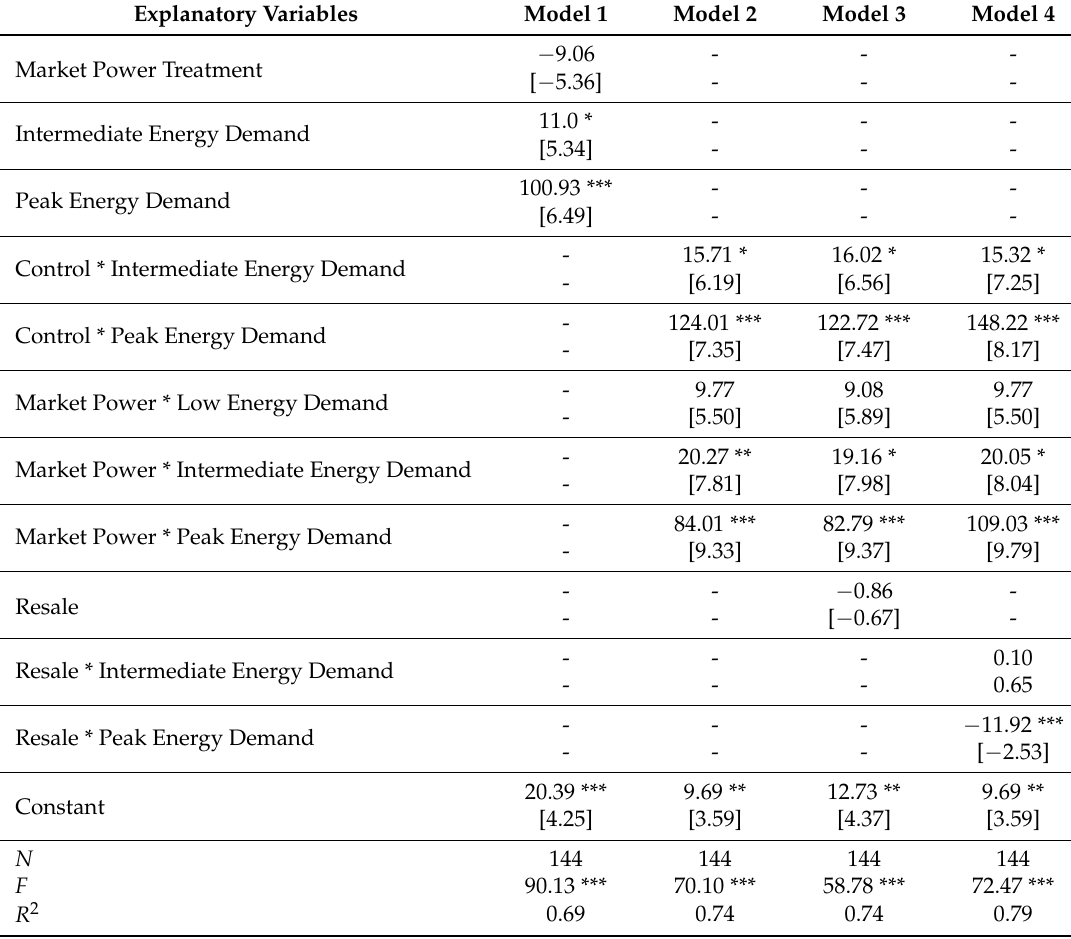
Table 5. Regression